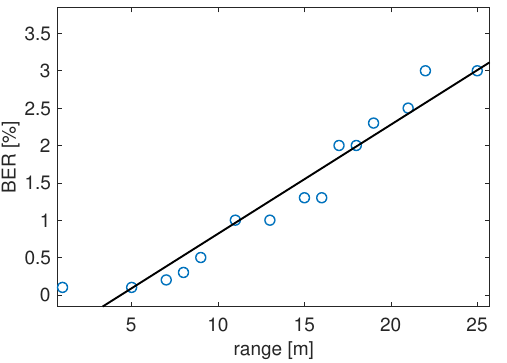
Figure 9. Communication performance in terms of BER as a function of the